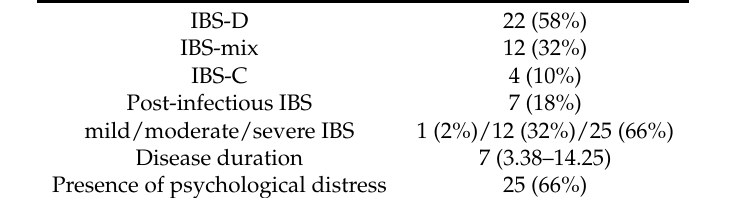
Table 1. Baseline sample characteristics.